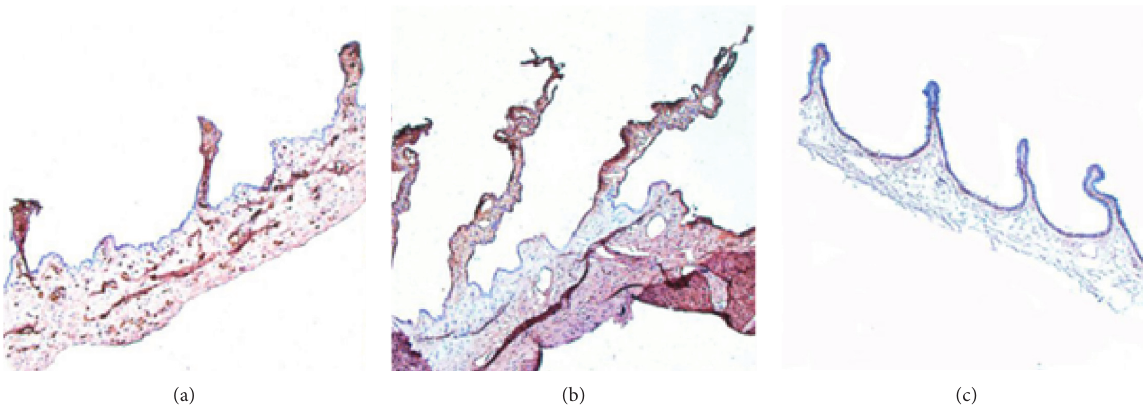
Figure 3: Distribution of MMP-1 in the UCP postoperative (a), cyclocryotherapy postoperative (b), and normal ciliary body (c). Magnification, ×